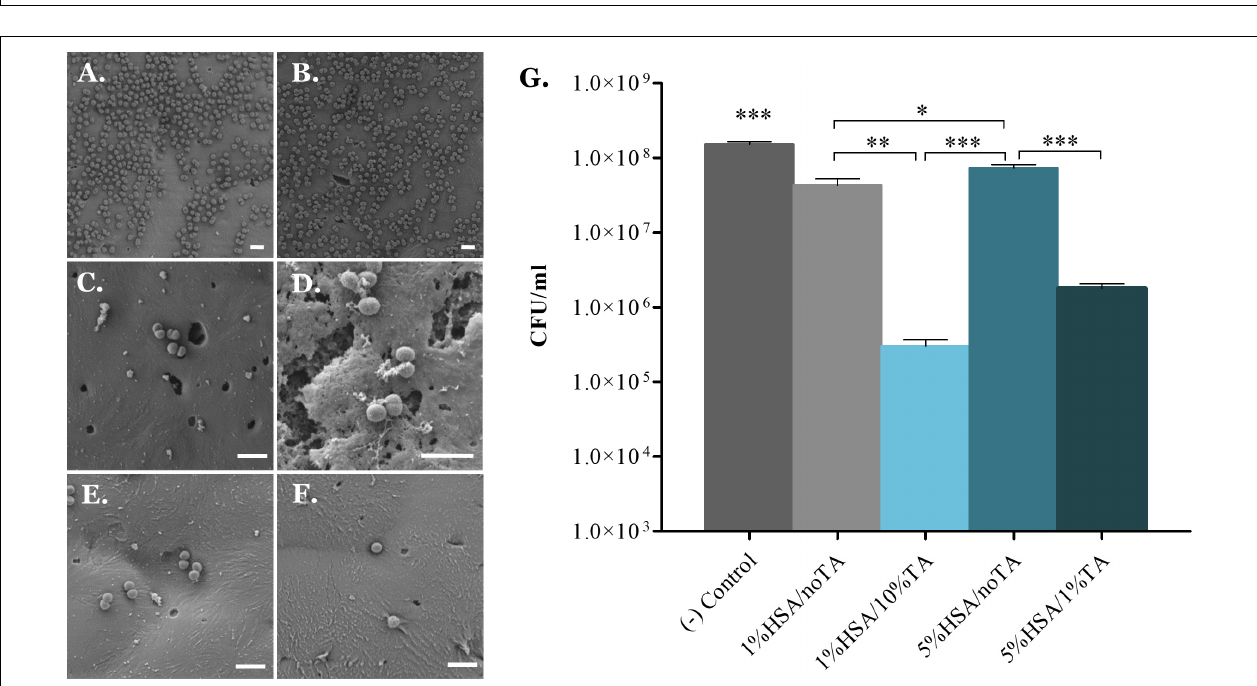
FIGURE 4 | In vitro evaluation of treated scaffolds in a 2D zone of inhibition assay against (A) gram-positive S. aureus and (B) gram-negative P. aeruginosa . 1%HSA/10%TA- and 5%HSA/1%TA- treated scaffolds exhibited antimicrobial activity against both bacteria strains seen in the form of a clear zone around the samples in the agar plate. (C) Comparison of inhibition zones by antibiotic-loaded disks (+Control) and HSA/TA-coated scaffolds. Data shown as mean ± SD, n = 8. ( ∗∗∗ p < 0.001).